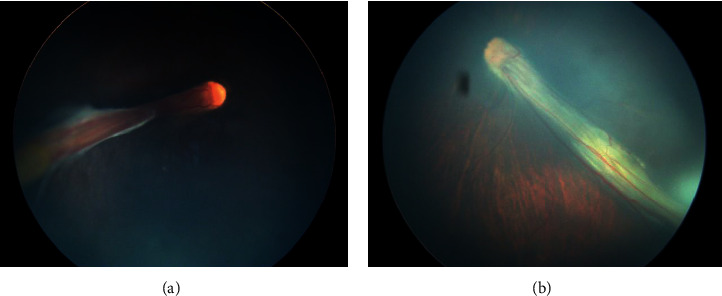
(a) Right eye fundus of case 8. (b) Left eye fundus of case 9. Stage 4b lesions were mostly manifested as falciform fold of the retina.